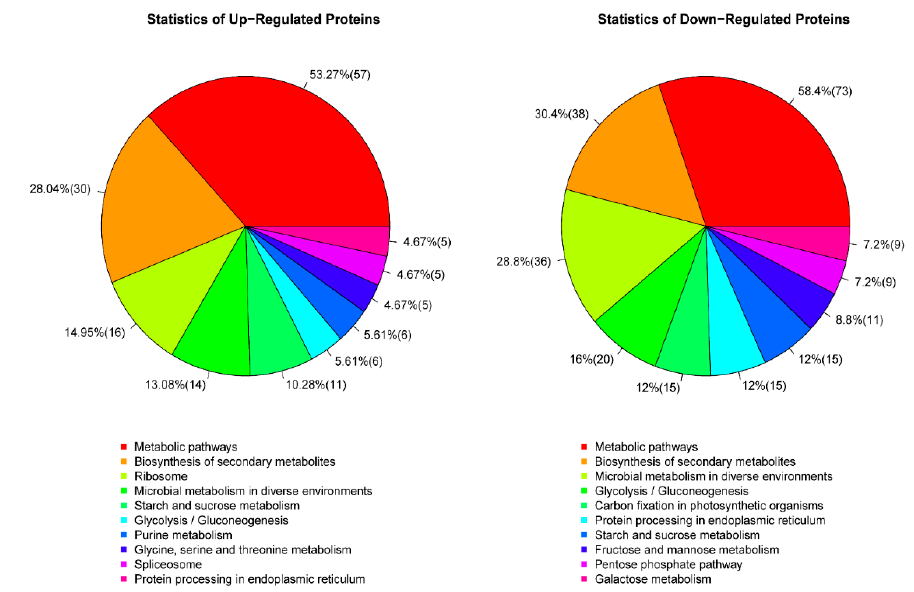
Figure 6. Statistics of Kyoto encyclopedia of genes and genomes (KEGG) pathways; DEPs in S727 (up- regulated proteins) and S3057 (down-regulated proteins). (up-regulated proteins) and S3057 (down-regulated